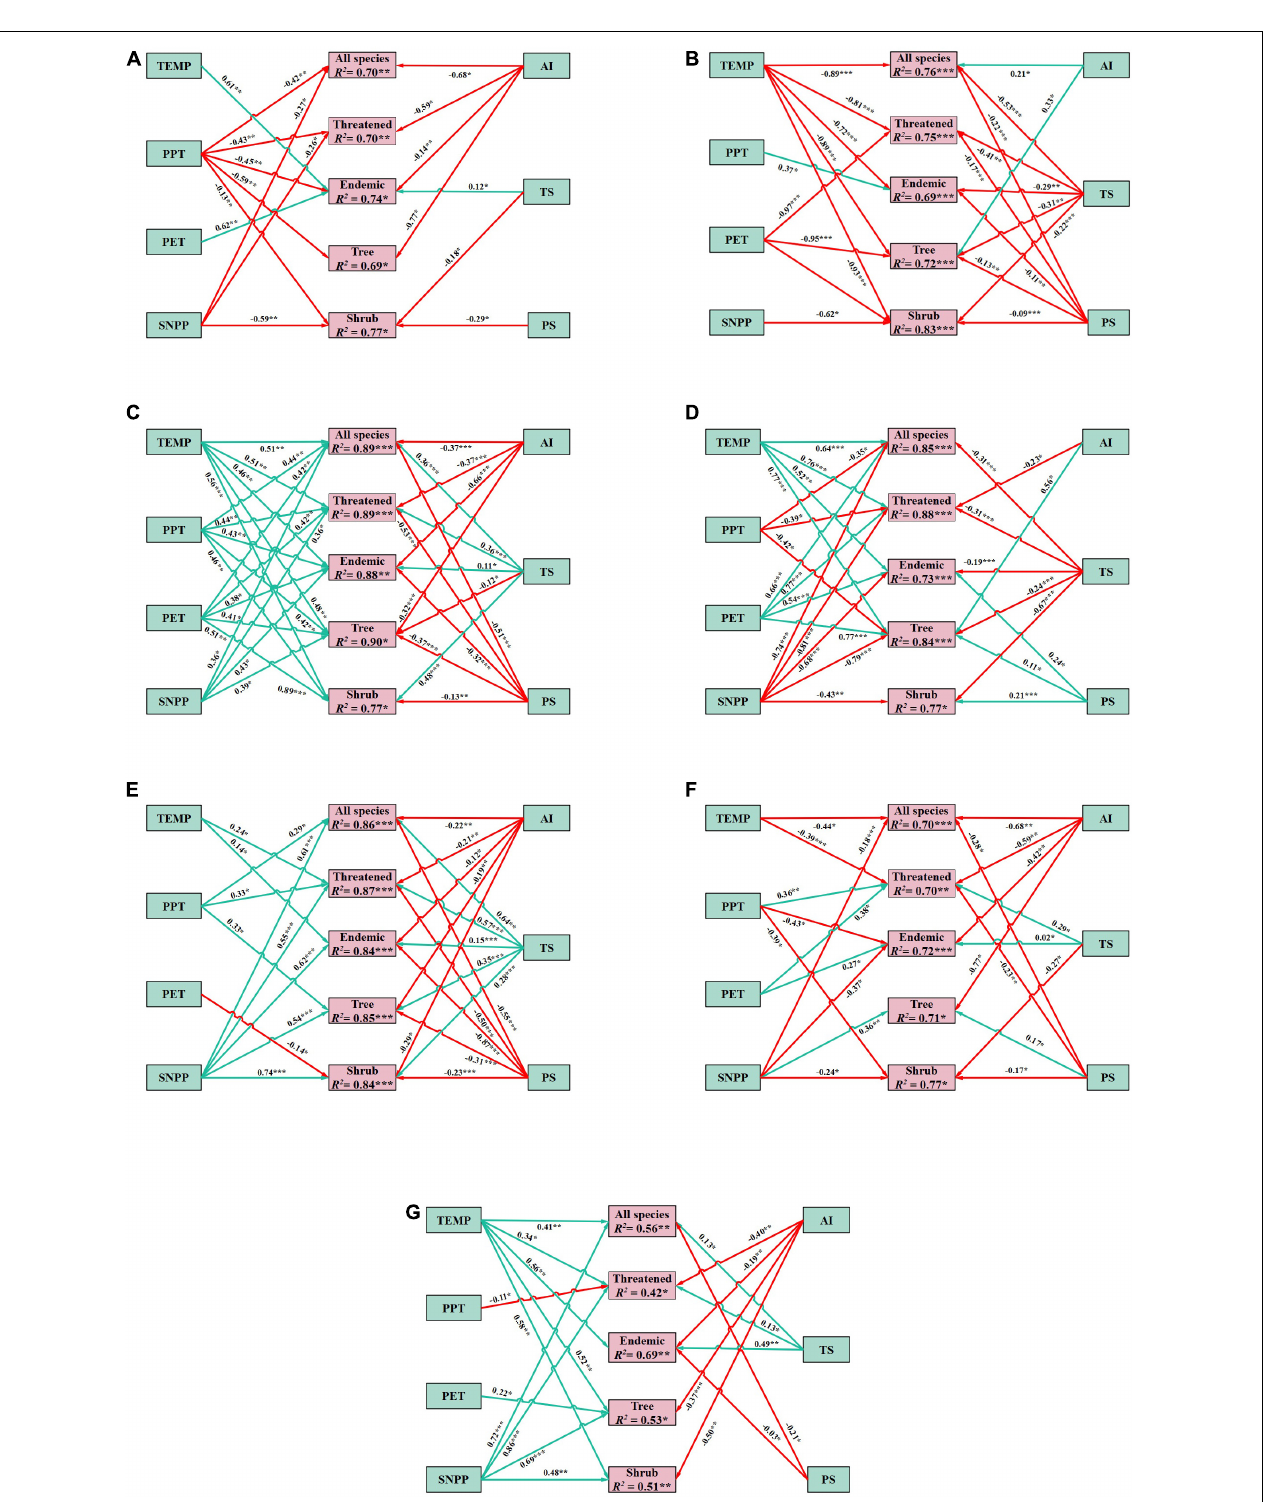
FIGURE 5 | Structural equation model (SEM) examining the influence of potential evapotranspiration (PET), mean annual temperature (TEMP), annual precipitation (PPT), net primary productivity (SNPP), aridity index (AI), temperature seasonality (TS), and precipitation seasonality (PS) on species richness of gymnosperms in ecoregions of China— (A) Eco 12, (B) Eco 19, (C) Eco 20, (D) Eco 22, (E) Eco 27, (F) Eco 33, and (G) Eco 34. The colors of the arrow represent positive (green) and negative (red) relationship; the number in the arrow denotes the standardized partial regression coefficients. Only significant variables were used in the figure. Significance: * p < 0.05; ** p < 0.005; *** p < 0.001.